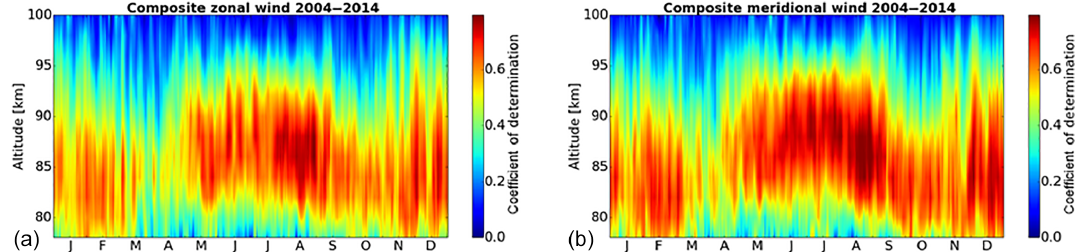
Figure 7. Composite of R 2 for the zonal (a) and meridional (b) component of the overlapped altitude of MF radar and meteor radar for the years 2004–2014. The data have been smoothed by using a 5-day running mean.